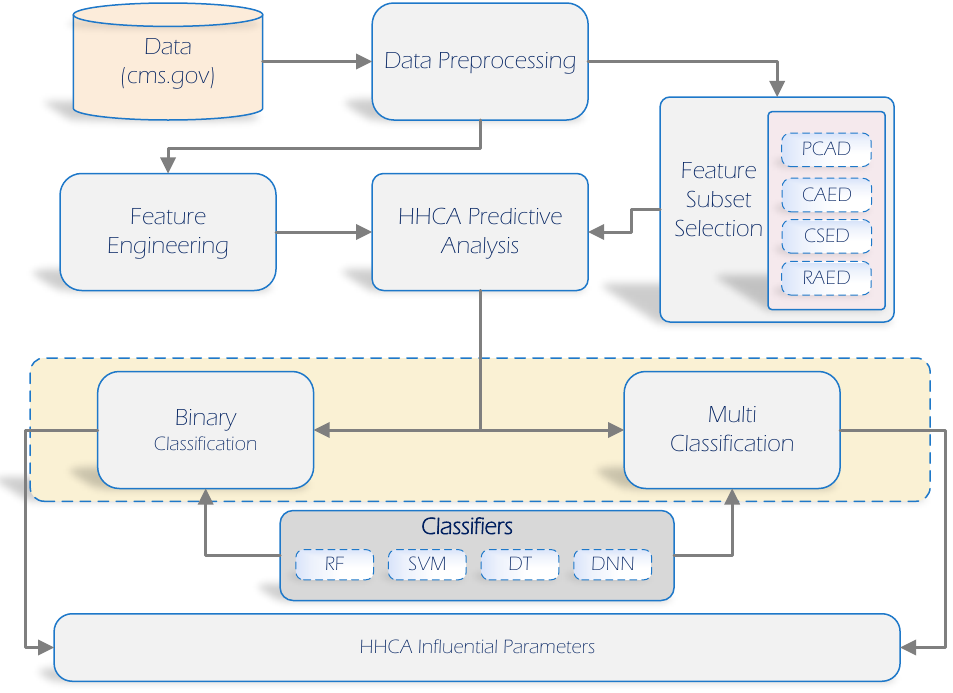
Figure 1. HHCA methodology and analysis